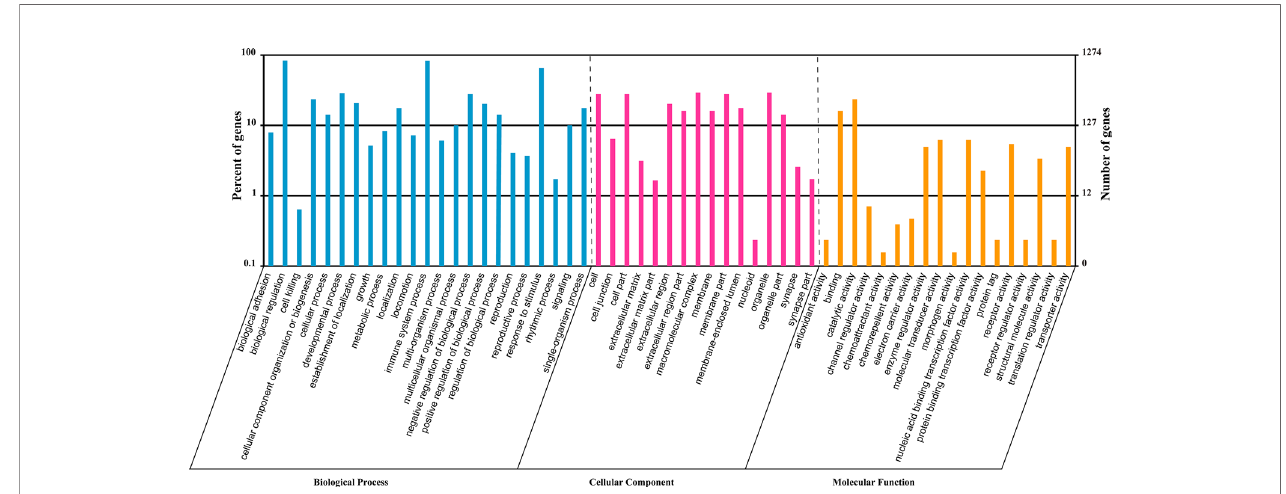
FIGURE 4 | GO analysis of the predicted targets for the 23 common SDE miRNAs. GO analysis was performed by the R package named Cluster Pro fi ler based on hyper-geometric distribution. The P -value was calculated through Fisher Exact Test and corrected by FDR. The corrected P -value<0.05 was considered as signi fi cant enrichment and showed in the